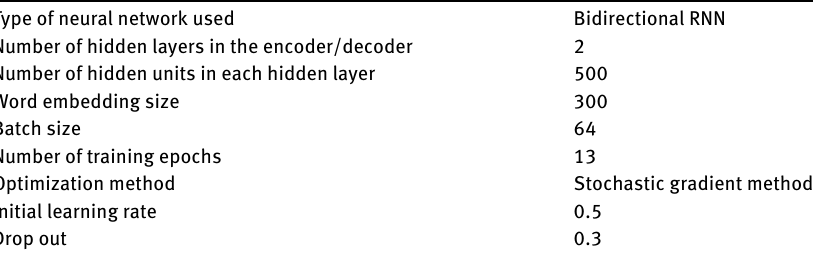
Table 7: Training Parameters.